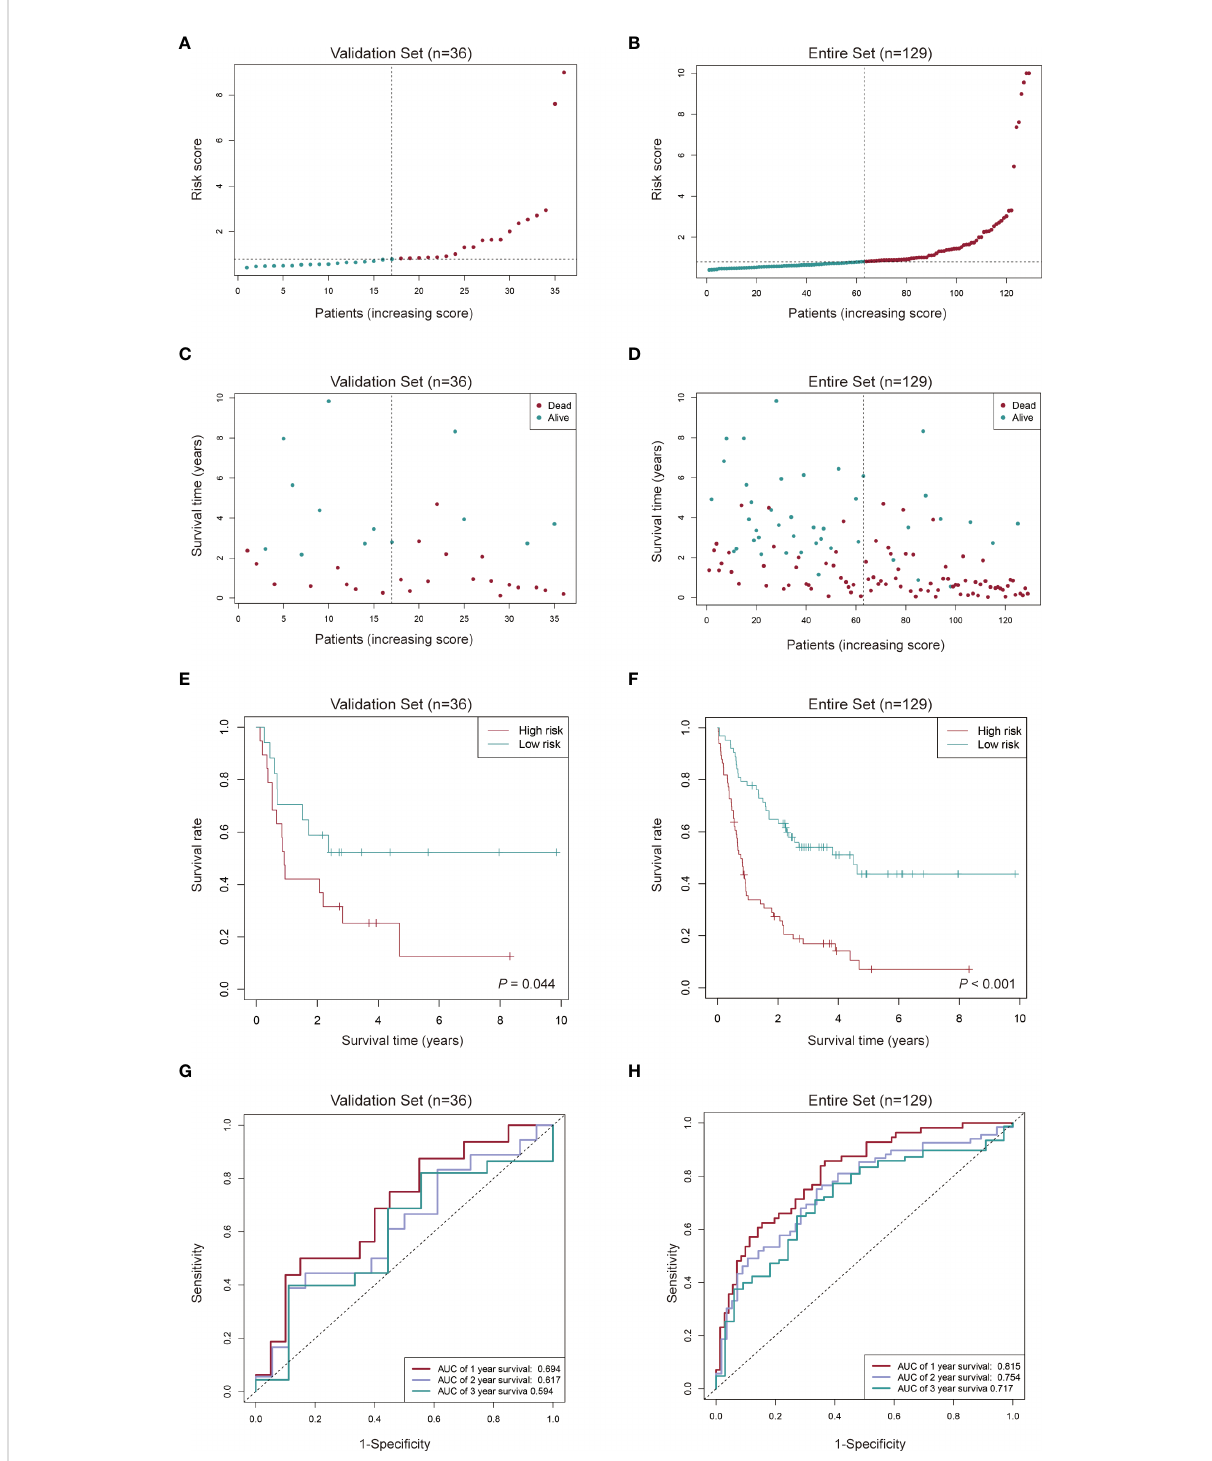
FIGURE 5 Evaluation of the cuproptosis-related lncRNA signature in the validation set and the entire set. (A-D) Distribution of the risk score and survival time of each patient in the validation set (A, C) and entire set (B, D) . (E, F) Kaplan-Meier curve analysis of the signature in the validation set (E) and entire set (F) . (G, H) ROC curves and their AUC values showed 1-, 2-, and 3-year predictions in the validation set (G) and entire set (H)